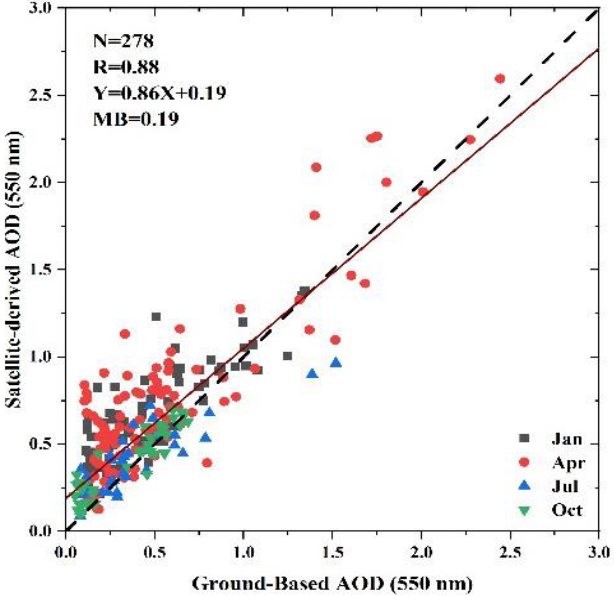
Figure A2. Scatter plot of the comparison between retrieved MODIS AOD and ground-based AOD monitored at AERONET sites (including January, April, July, October) in 2019. The correlation coefficient (R) was 0.88 (N = 278).